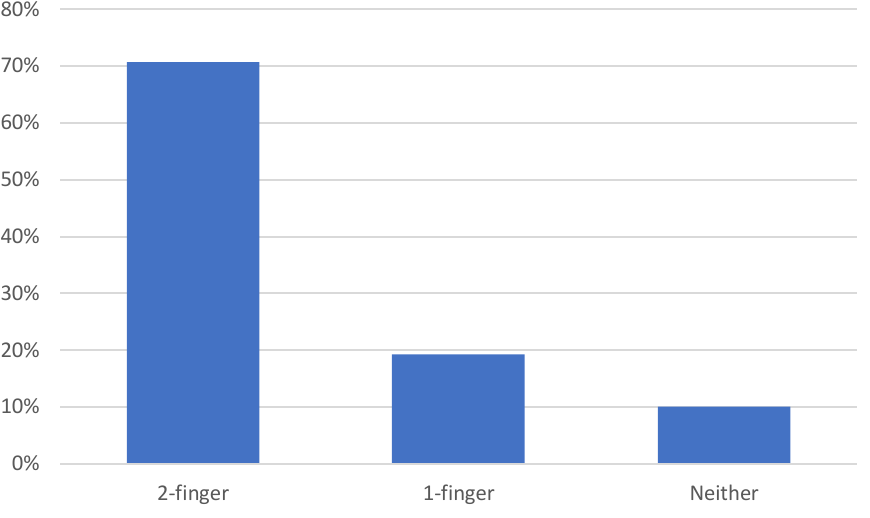
Figure 3. The percentage of horses ( n = 546) meeting the 2-finger, 1-finger or neither noseband meas- urement when measured by Pilot Stewards using the ISES taper gauge at Canadian equestrian com- petitions in 2021.